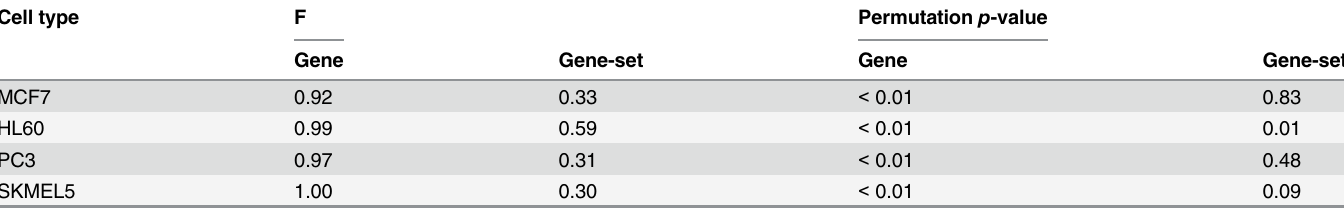
Table 1. Cell-type effects are eliminated in hierarchical clustering based gene-set